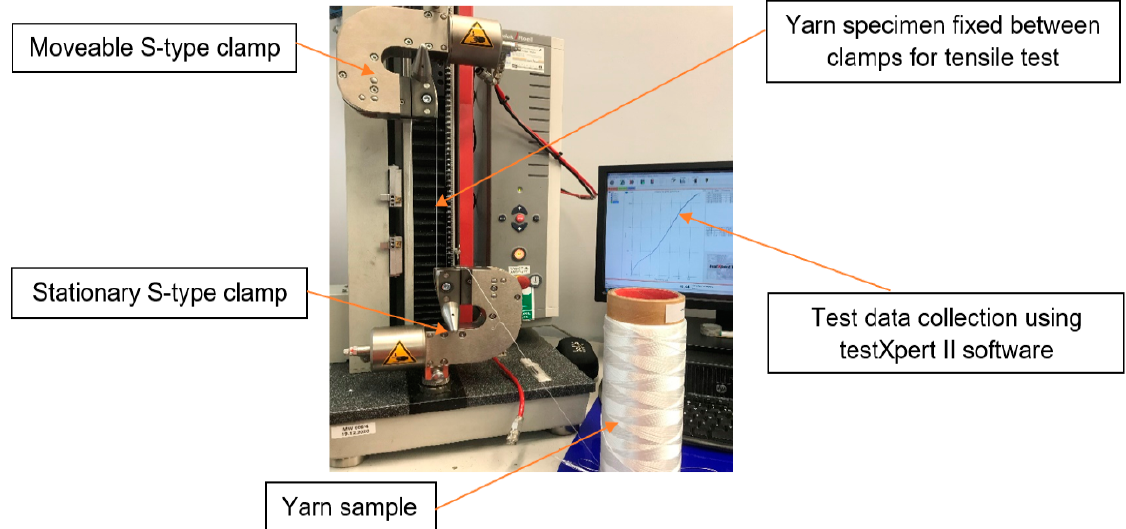
Figure 2. Zwick/Roell tensile